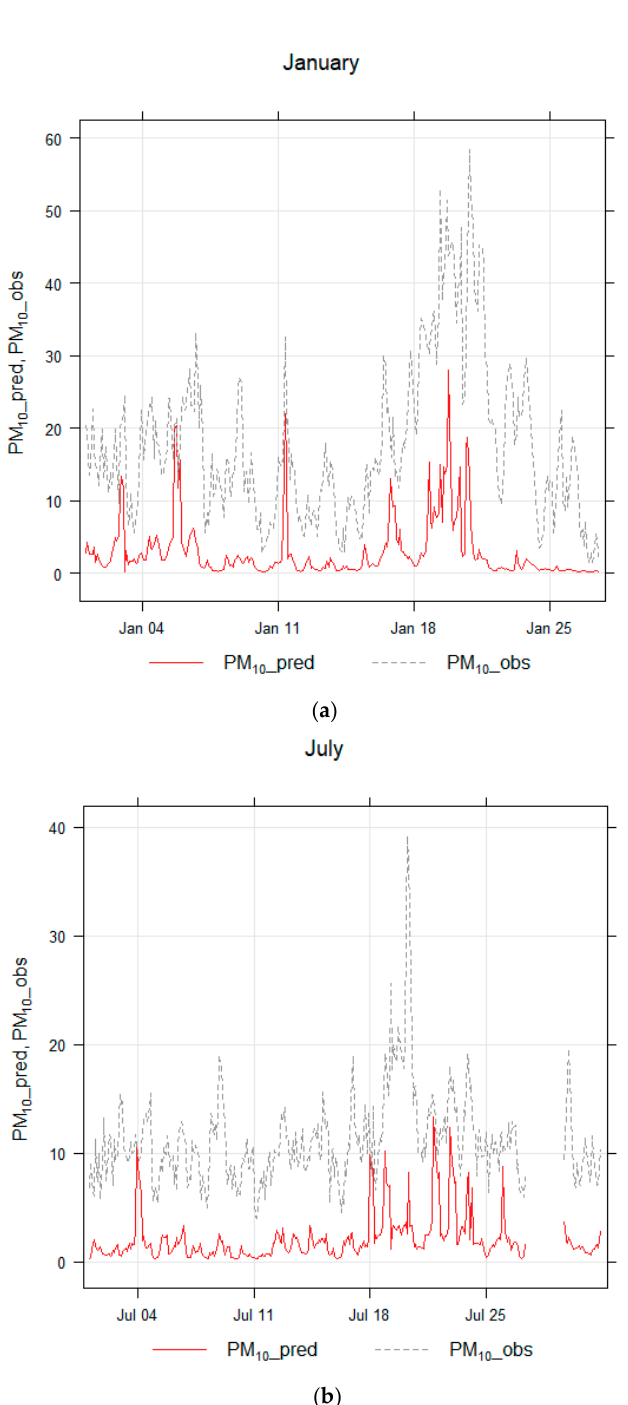
Figure 11. A comparison of measured and predicted PM 10 concentrations ( µ g / m 3 ) at Devonshire Green